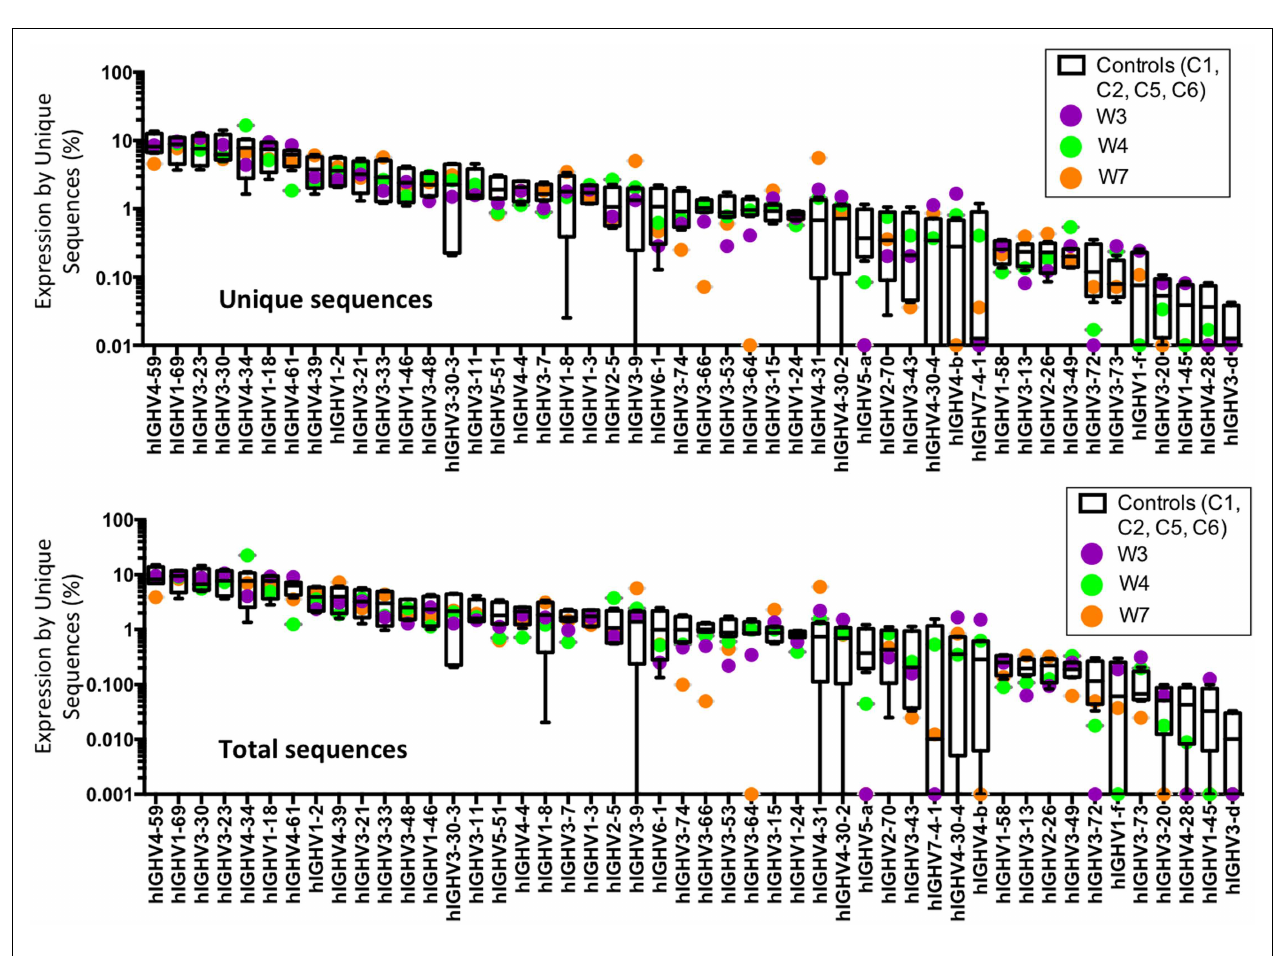
high, low, and median values, and error bars indicate the 5th and 95th percent confidence intervals for controls.WAS patients are identified by filled